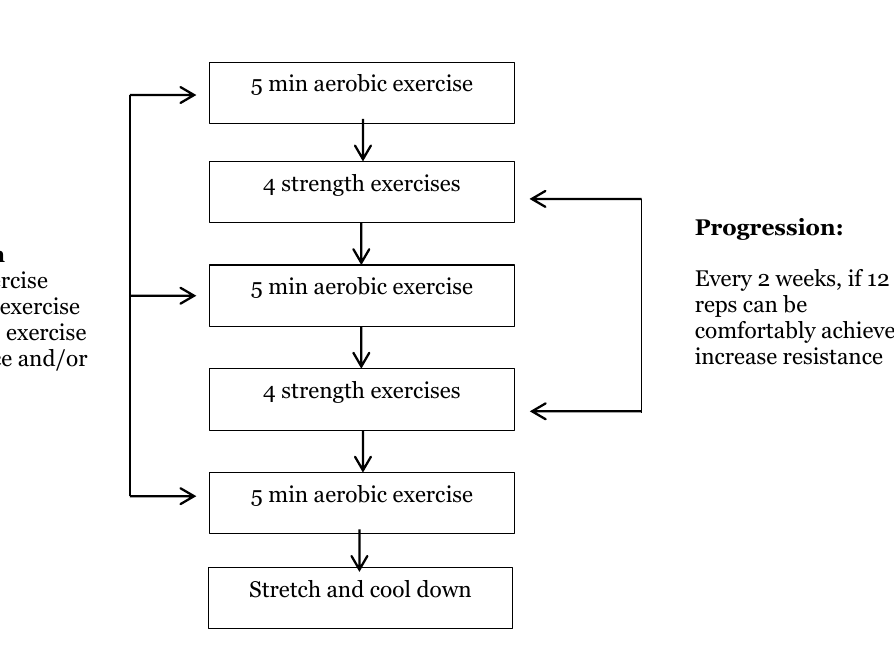
Figure 2 . Exercise content. The 8 strengthening exercises were: Leg press (or leg extensions), plantarflexor strengthening (TheraBands or toe raises), trunk rotation ball twist while seated on Swiss ball), single leg stand or dip, hip extensor strength (standing or in kneeling), dorsiflexor strength (walking on heels, seated dorsiflexion), squats, hip abductor strength (standing or side